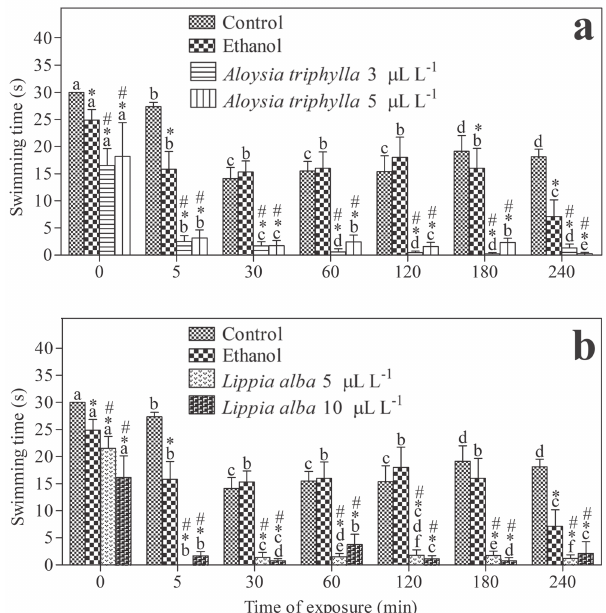
Fig. 2. Swimming time of Serrasalmus eigenmanni exposed to a. A. triphylla essential oil. b. L. alba essential oil. Different letters indicate significant differences at each exposure time between treatments based on the non-parametric Scheirer-Ray-Hare extension of the Kruskal-Wallis test, followed by a post-hoc Nemenyi test. * indicates a significant difference from control fish. # indicates a significant difference from ethanol- exposed fish.